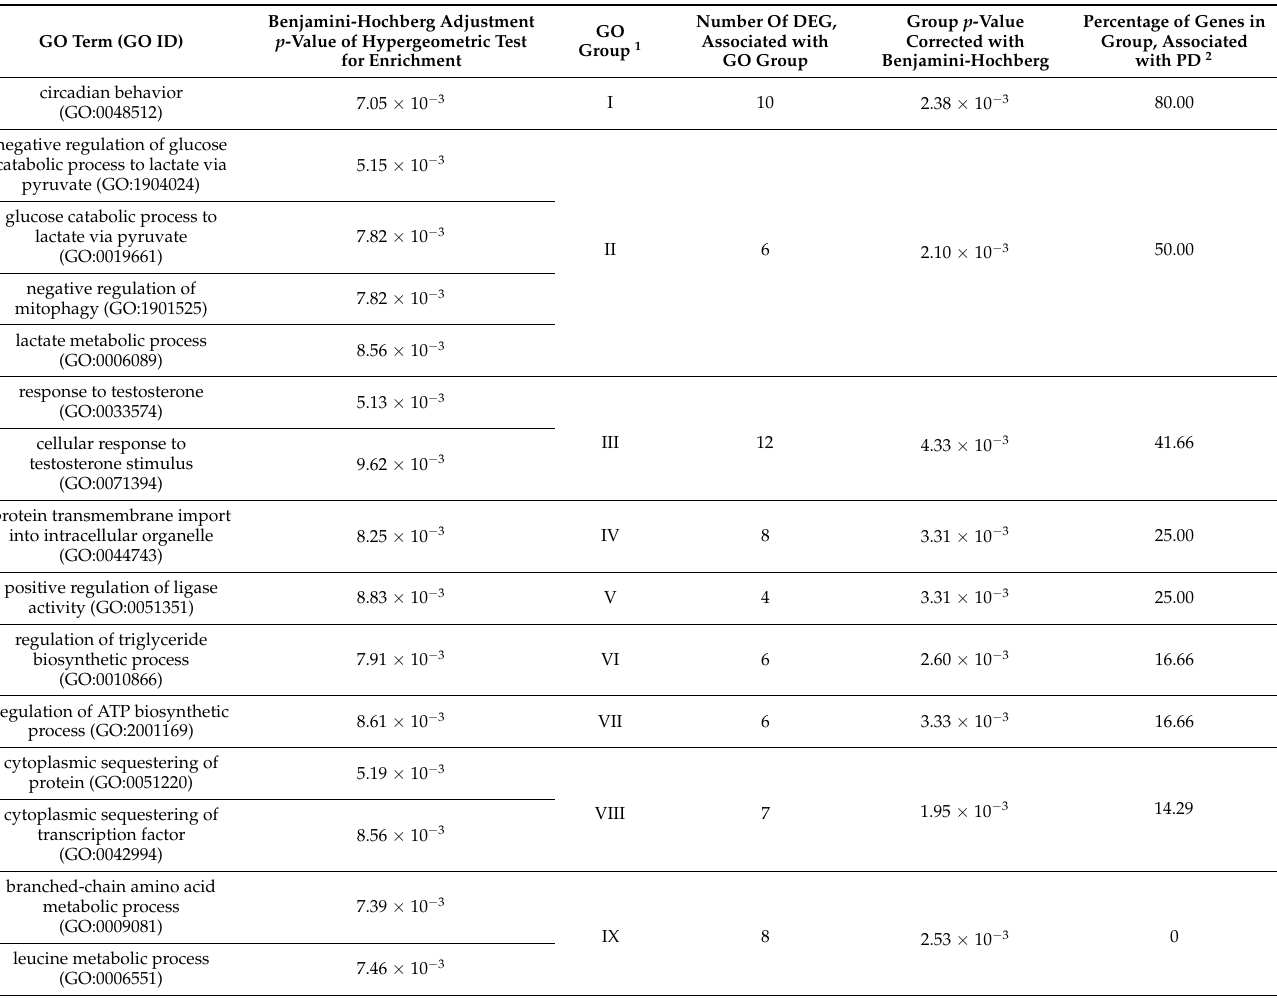
Table 3. The results of enrichment analysis of data obtained by RNA-seq analysis of the peripheral blood of twins discordant for